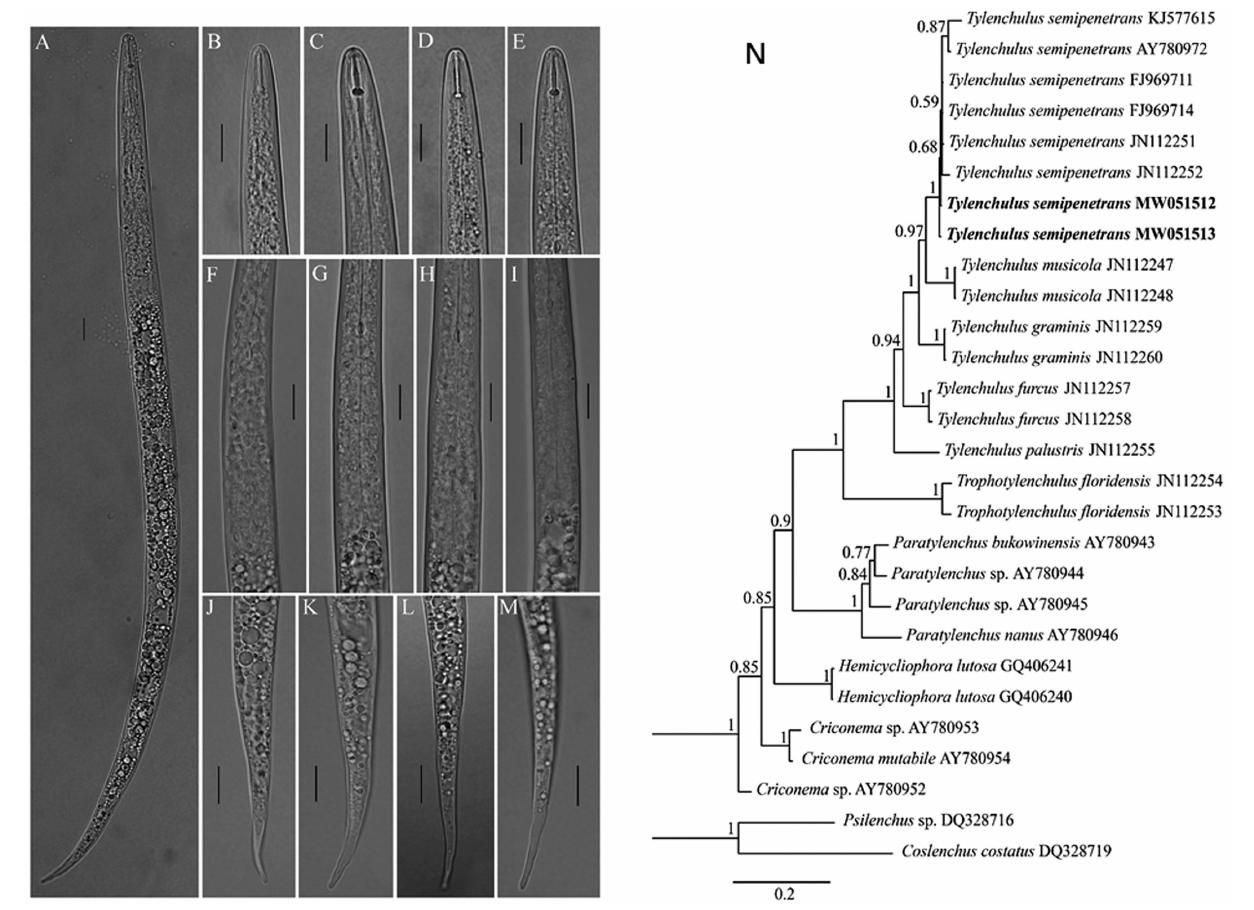
FIGURE 1 | Light photomicrographs of Tylenchulus semipenetrans juveniles and Bayesian tree. (A) Entire body. (B–E) Anterior body region. (F–I) Esophageal glands; (J–M) Tail (Scale bars = 10 µ m.). (N) Bayesian tree inferred from Tylenchulus spp. and other nematodes based on D2–D3 of 28S ribosomal DNA. Posterior probability values exceeding 50% are given on appropriate clades. New sequences original to this study are indicated in